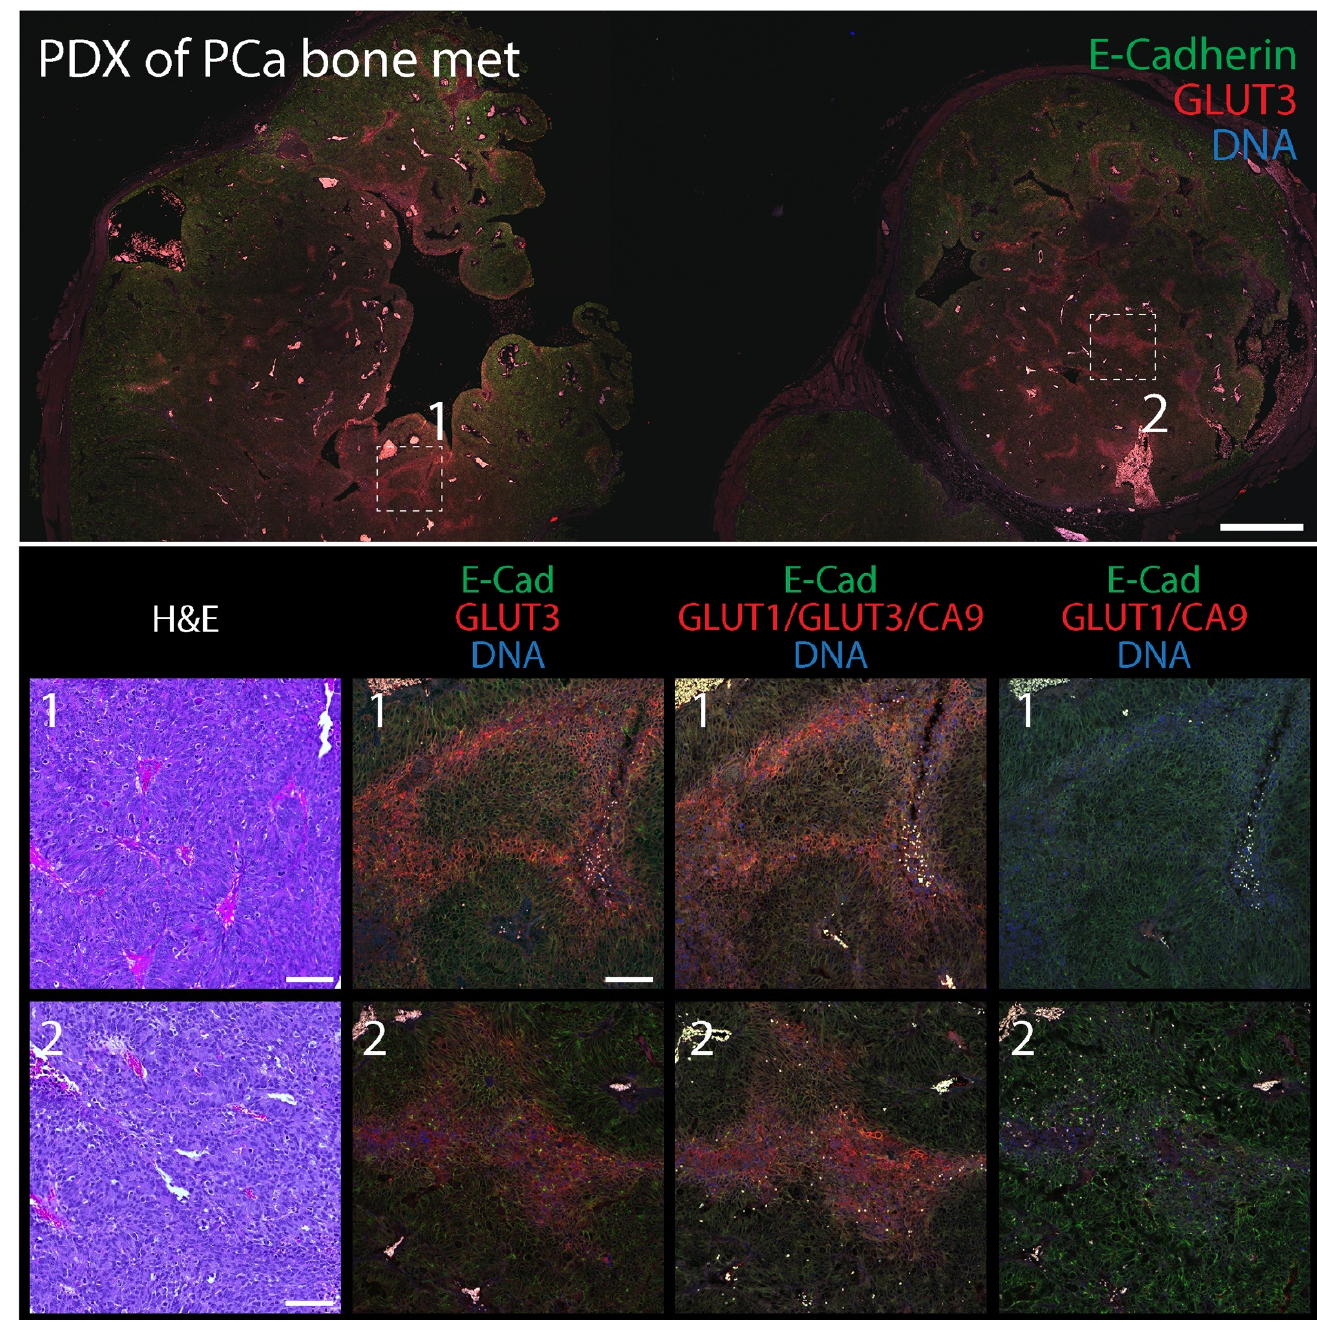
Figure 7. Patient-derived xenograph (PDX) model of bone metastatic prostate cancer contains distinct pockets of GLUT3 staining. (Upper panel) Section of PDX tumor immunostained for E-Cadherin (green) to mark cell borders and GLUT3 (red). DNA, blue. Boxed regions are shown at higher magnification (lower panels). Scale, 500 μ m. (Lower panels) Higher magnification images from boxed regions 1 or 2 in upper panel. Serial tissue sections were stained with H&E (column 1) or immunostained for either GLUT3 (red, column 2), a cocktail containing anti-GLUT1, GLUT3, and CA9, antibodies (red, column 3), or antibodies against GLUT1 and CA9 (red, column 4) as indicated. Dashed white boxes show GLUT3 concentrated at the plasma membrane in tumor cells (insets). Scale, 100 μ m.